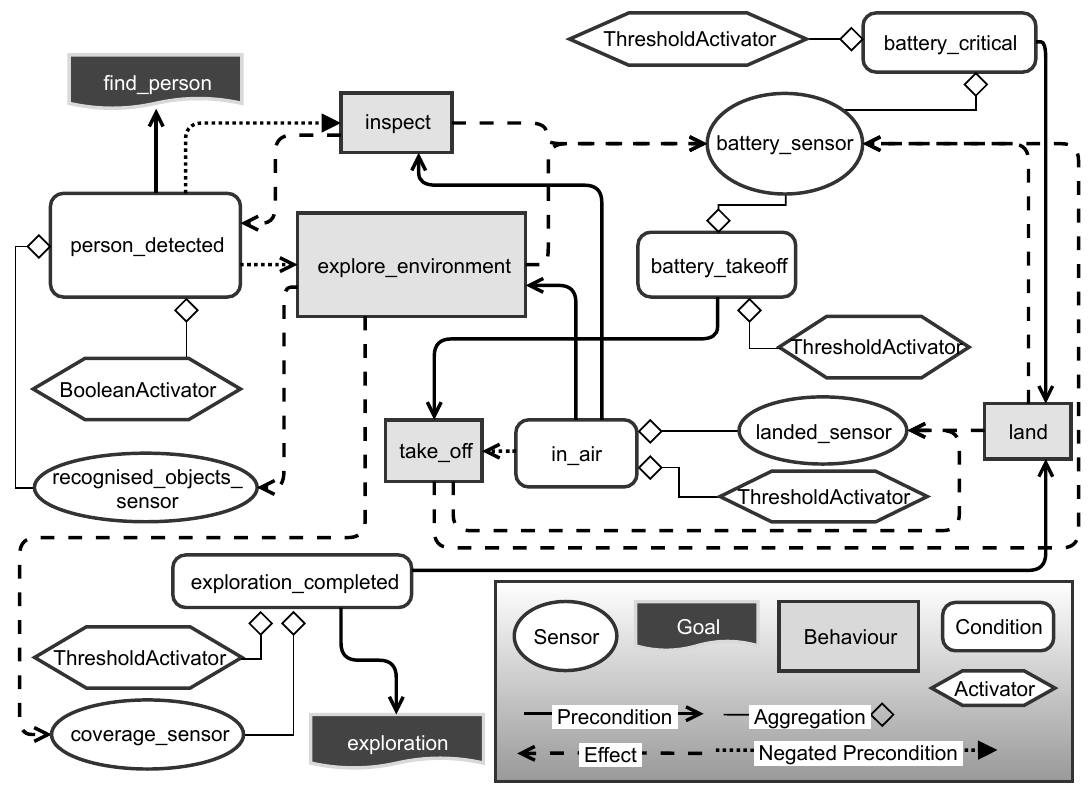
Figure 12. Behaviour network model of the milestone demonstrator